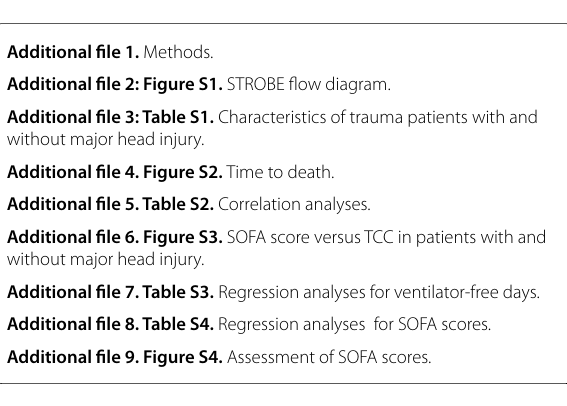
Additional file 2: Figure S1. STROBE flow diagram.